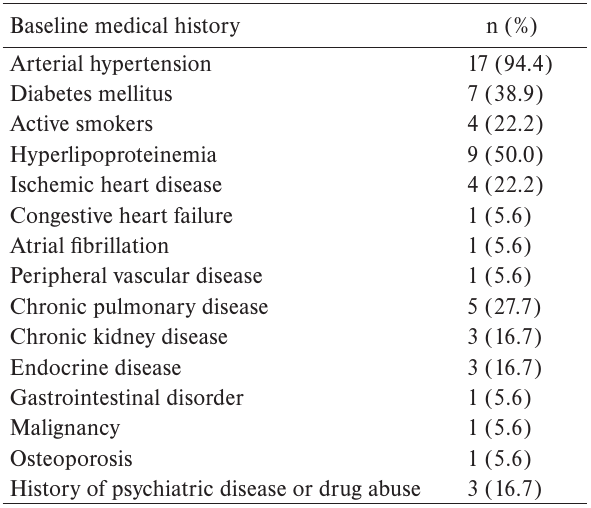
Table 1. Baseline medical history of the patients.